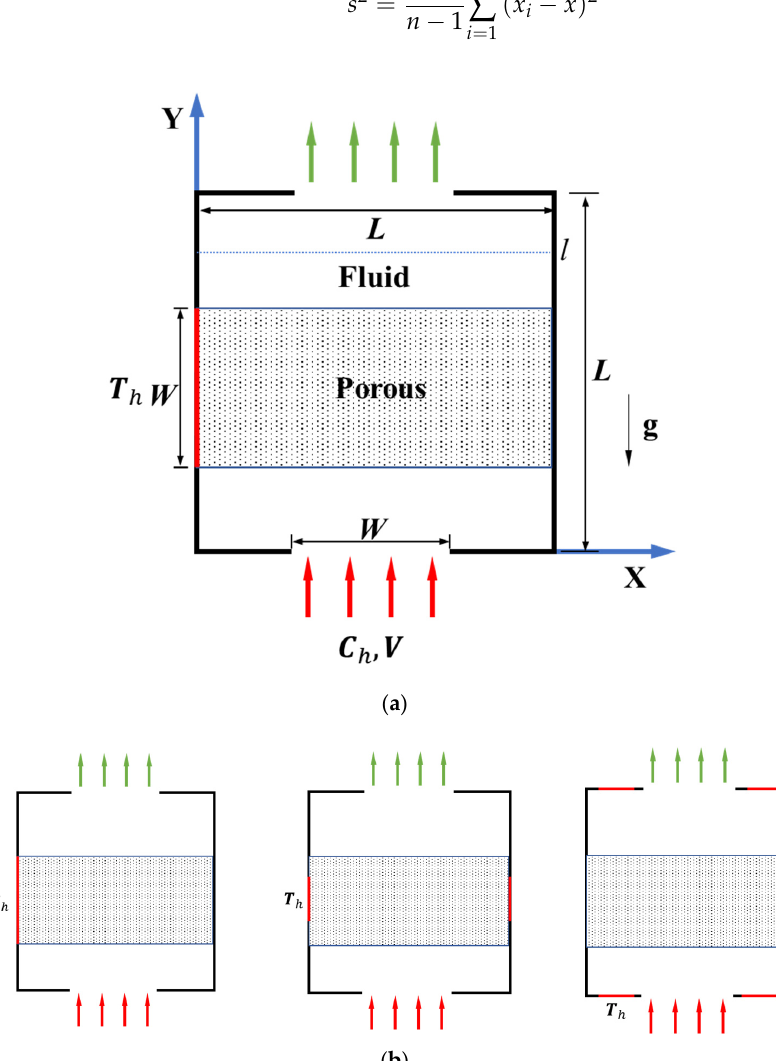
Figure 2. ( a ) Schematic of calculation coordinates and( b ) heat arrangements